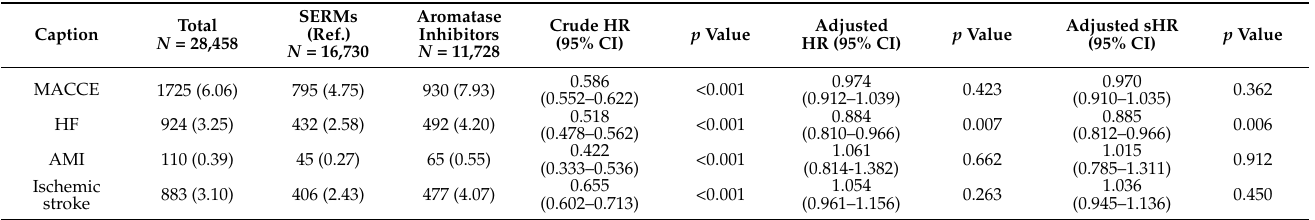
Table 2. The crude and adjusted hazard ratio (HR) of MACCE, AMI, HF and ischemic stroke in users of SERMs and AIs in NHIRD